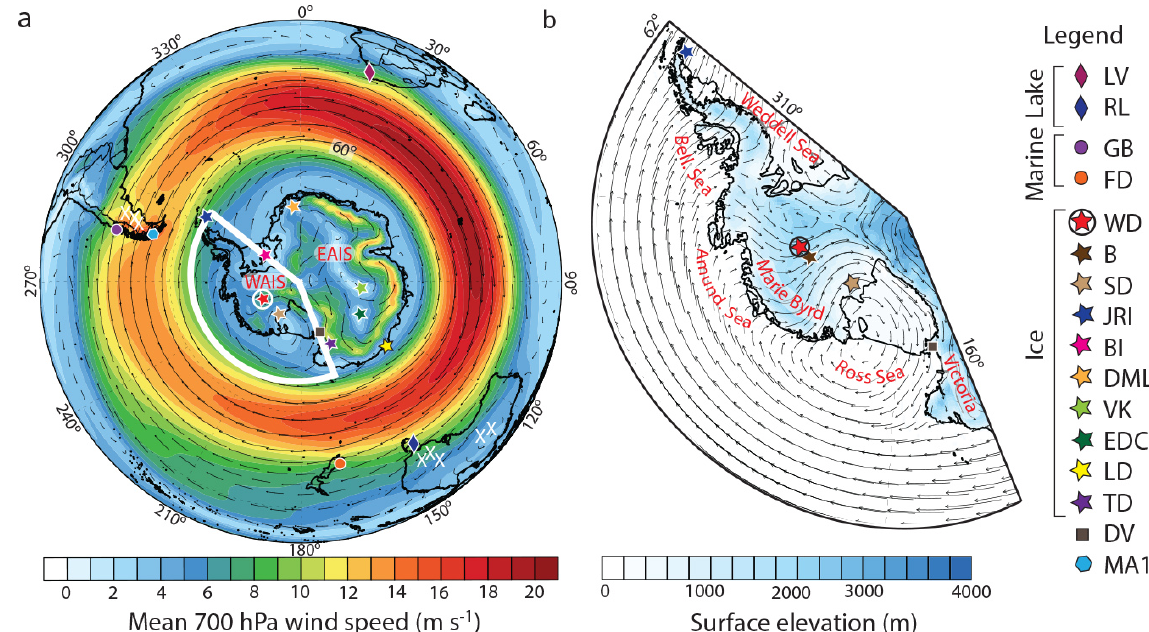
Figure 1. (a) Map of the Southern Hemisphere showing mean (1979–2010) annual wind speed (colors) and direction (vectors) at 700hPa from ERA-Interim reanalysis data, major SH dust sources (white Xs), and locations of sites discussed in the text, as indicated (lake cores: LV: Lake Verlorenvlei; RL: Rebecca Lagoon. Marine cores: GB: GeoB 3313-1; FD: Fiordland. Ice cores: WD: WAIS Divide; B: Byrd; SD: Siple Dome; JRI: James Ross Island; BI: Berkner Island; DML: EPICA Dronning Maud Land; VK: Vostok; EDC: EPICA Dome C; LD: Law Dome; TD: Talos Dome. DV: Dry Valleys. MA1: Marcelo Arévalo Stalagmite; WAIS: West Antarctic Ice Sheet; EAIS: East Antarctic Ice Sheet; Victoria: Victoria Land; Marie Byrd: Marie Byrd Land). (b) Map of the WAIS region showing elevation (blue shading), annual average 700hPa wind vectors from ERA-Interim reanalysis data, and site locations, as indicated.